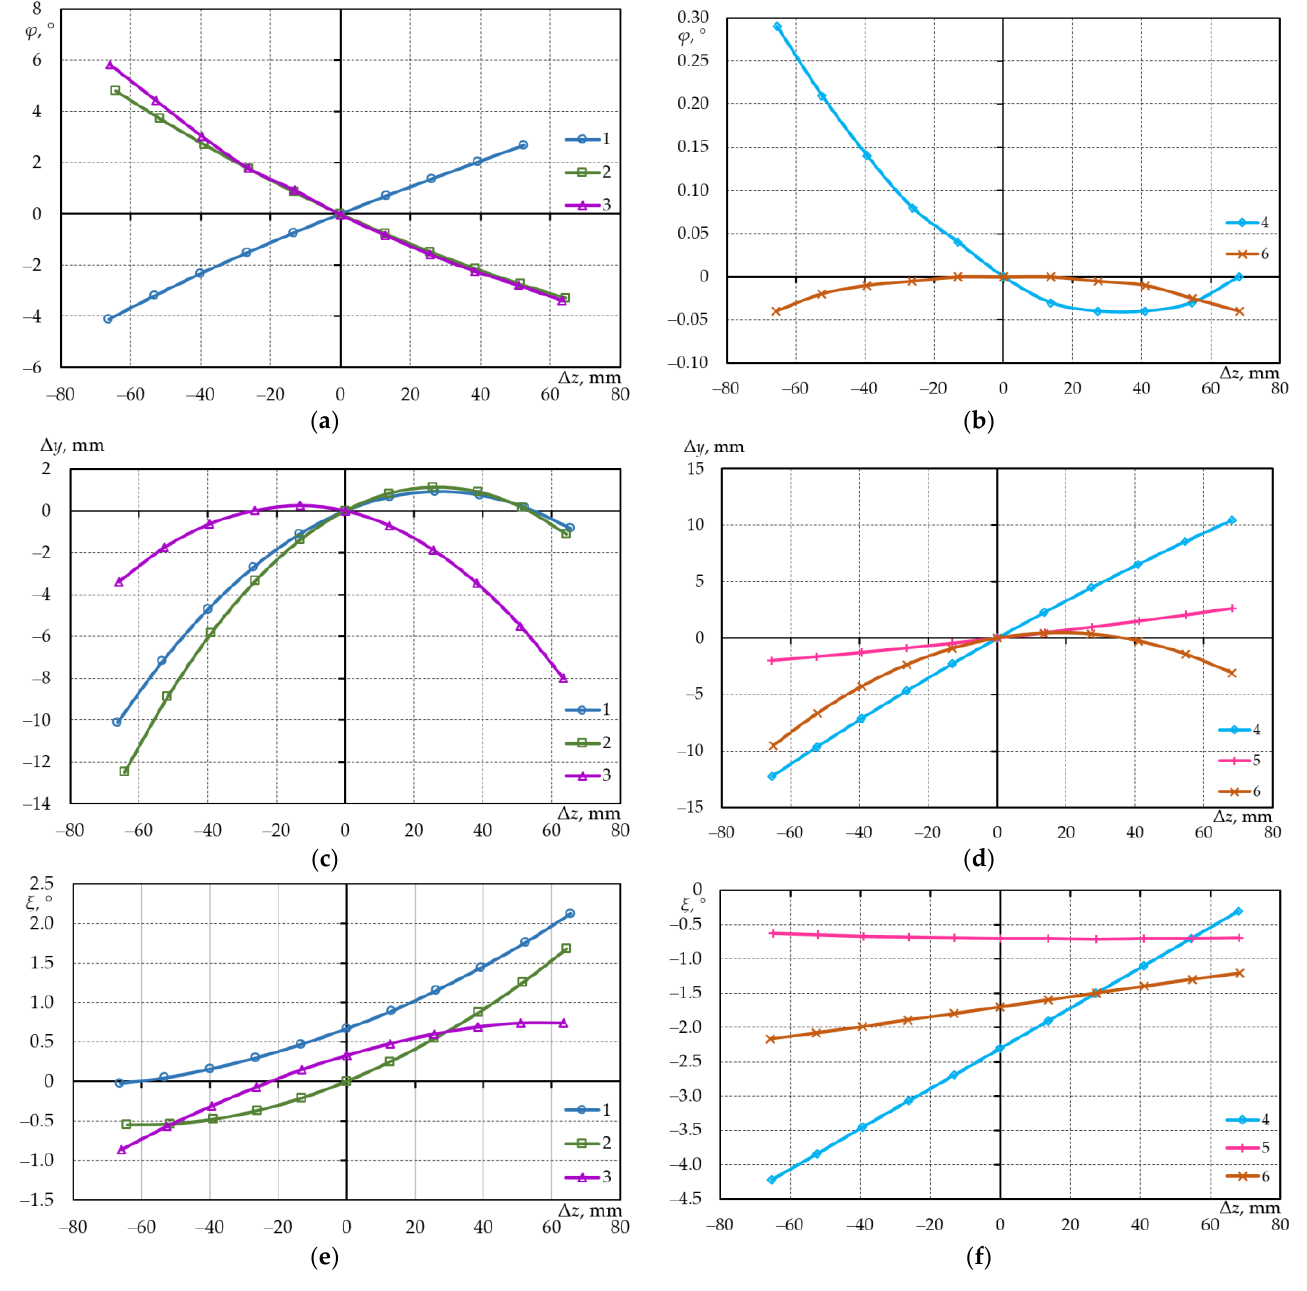
Figure 21. Dependence of front ( a , c , e ) and rear ( b , d , f ) suspensions on wheel position as a function of the vertical travel of the wheel: the turning angle of the wheels ( a , b ), transverse displacement of the wheels ( c , d ), wheel camber ( e , f ) (marking according to Table 2).